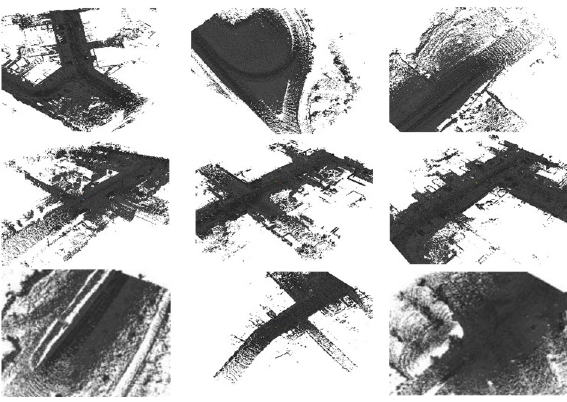
Figure 7. Pseudocode for NDT registration algorithm.